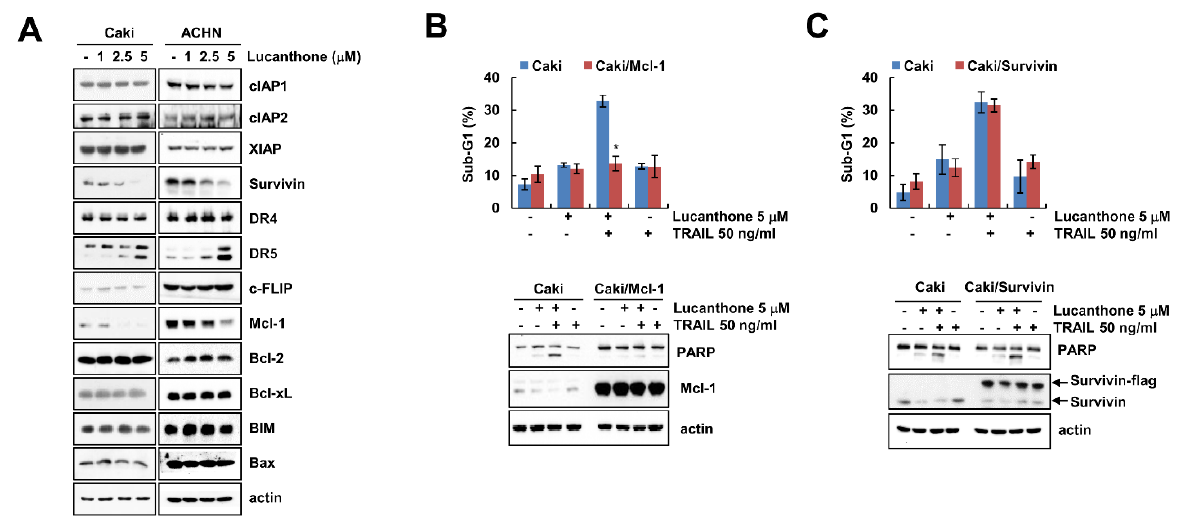
Figure 2. Lucanthone induces Mcl-1 downregulation and DR5 upregulation. ( A ) Caki and ACHN cells were treated with the 1-5 μM lucanthone for 24 h; ( B,C ) Caki and Mcl-1- or survivin-overexpressed Caki cells ( B ) Caki/Mcl-1 or ( C ) Caki/survivin) were treated with 5 μM lucanthone or/and 50 ng/mL TRAIL for 24 h. ( A–C ) The protein expression and ( B,C ) sub-G1 population were measured by Western blotting and flow cytometry, respectively. The values in graph represent the mean ± SD of three independent samples. * p < 0.05 compared to the combinations of lucanthone and TRAIL in Caki cells.